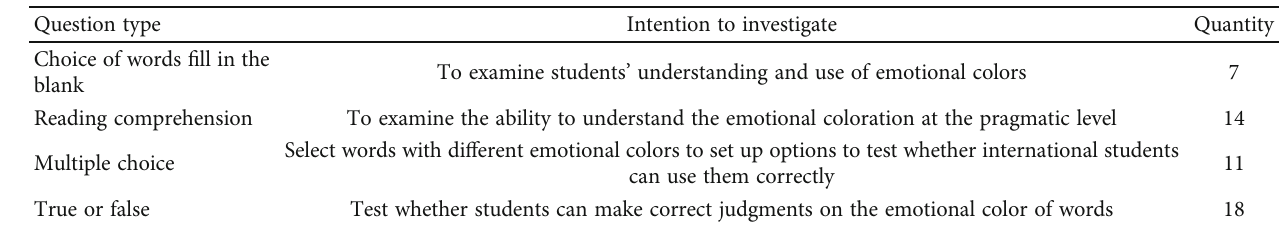
Figure 2: Visualization of the basic situation of the surveyed subjects. (a) Chinese pro fi ciency; (b) age distribution; (c) gender ratio. Table 1: Questionnaire